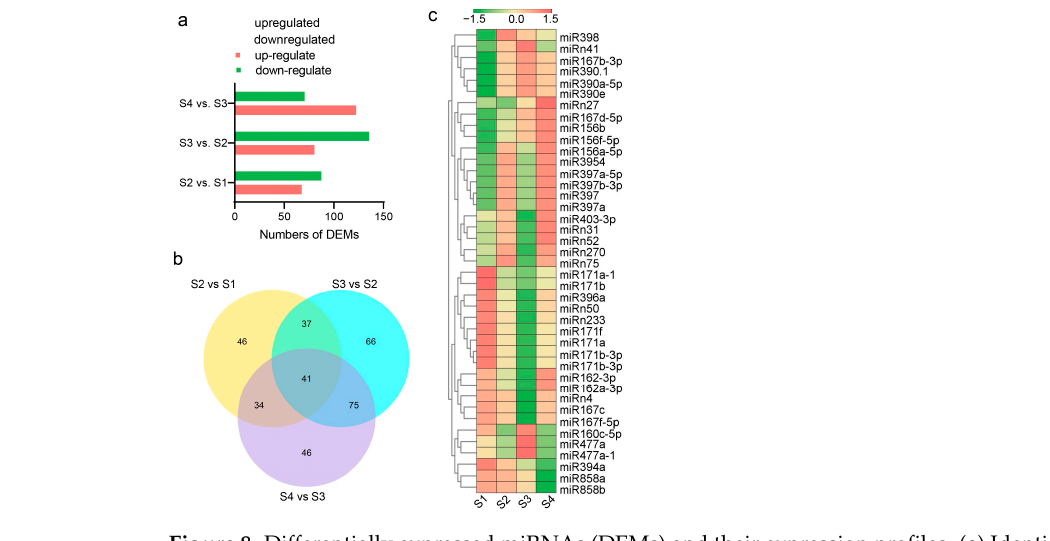
Figure 8. Differentially expressed miRNAs (DEMs) and their expression profiles. ( a ) Identified DEMs in S2 vs. S1, S3 vs. S2, and S4 vs. S3. ( b ) Venn diagram of DEMs in all three comparisons. ( c ) Heatmap of the expression levels of 41 DEMs that existed in all three comparisons.